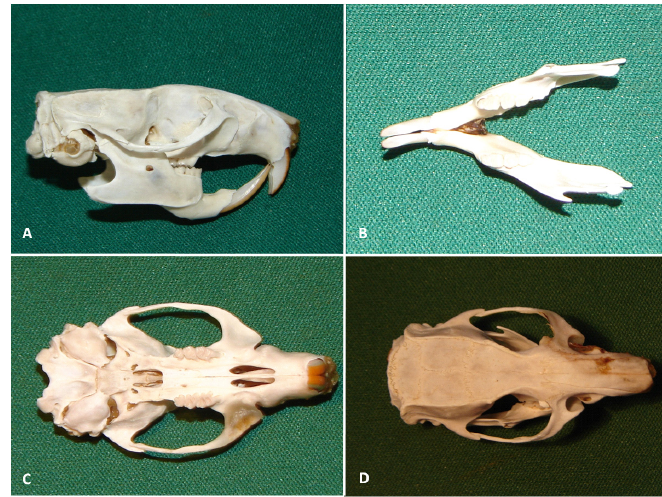
FIGURE 2 - Macroscopical evaluation of the hard tissue. A. Lateral view of the TMJ complex. B. Superior view of the mandible. C. Inferior view of the glenoid fossa. D. Superior view of the TMJ